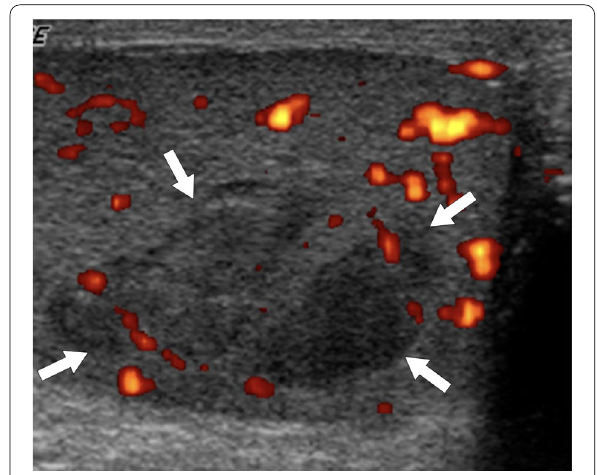
Fig. 12 Isolated testicular vasculitis. A 35-year-old healthy male with progressive severe testicular pain and palpable mass on physical exam. Power Doppler ultrasound image demonstrates a hypoechoic peripherally located testicular mass (arrows) with mild increase in perilesional blood flow. Orchiectomy revealed necrotizing vasculitis and hemorrhagic infarct. There was no evidence of systemic vasculitis elsewhere in the body in the post-operative medical evaluation